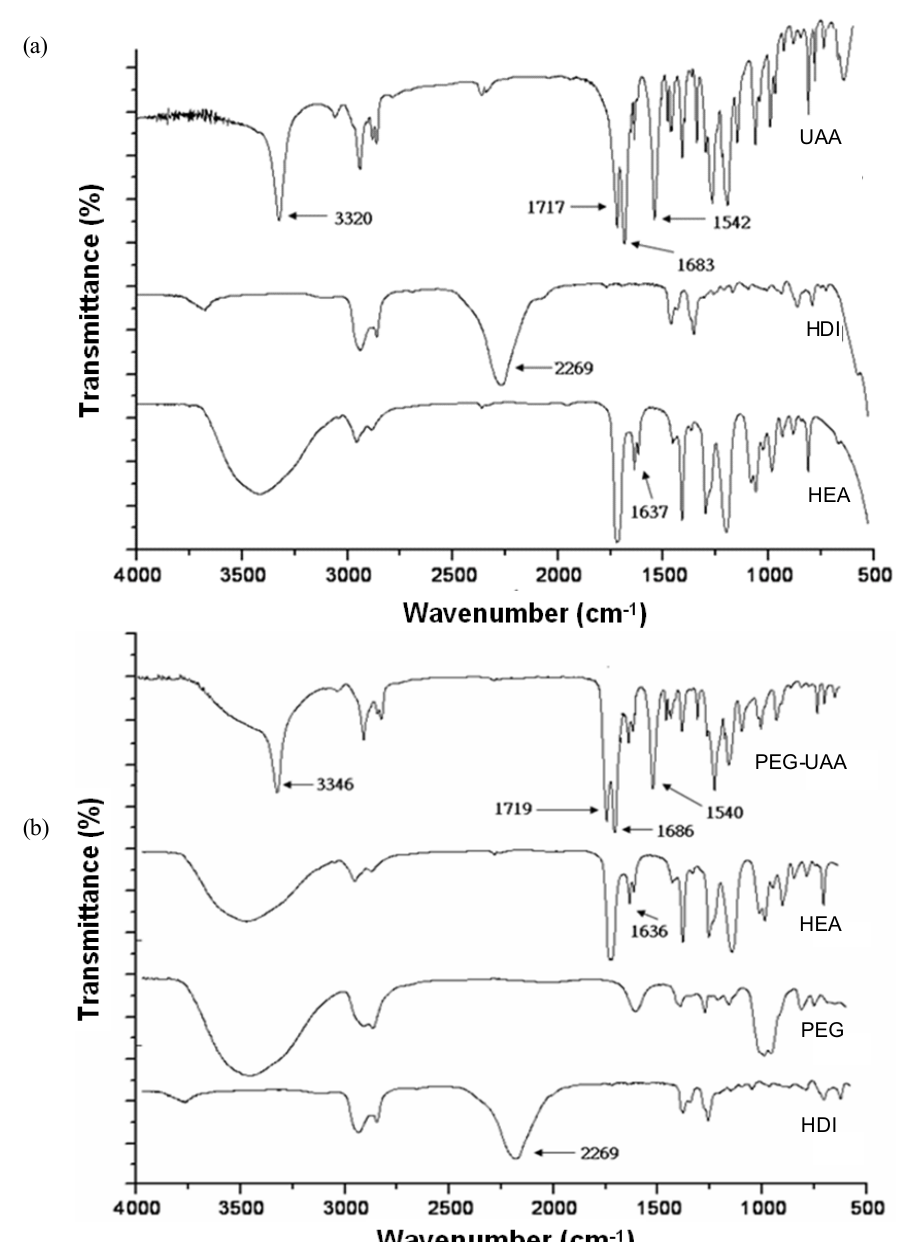
Figure 1. The infrared spectra analysis of ( a ) UAA; ( b )